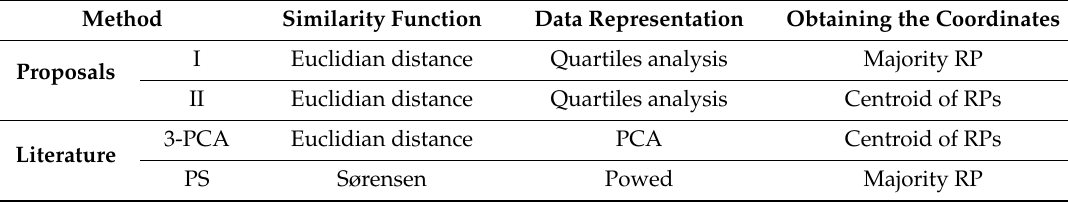
Table 4. Techniques of the covered methods and the methods presented in the literature.